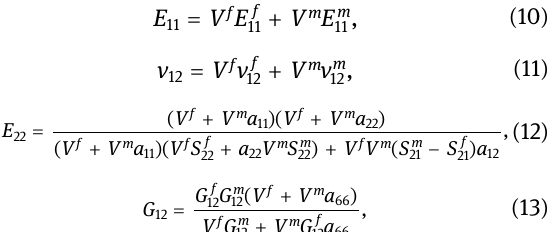
Figure 3: RVE model after discretization of